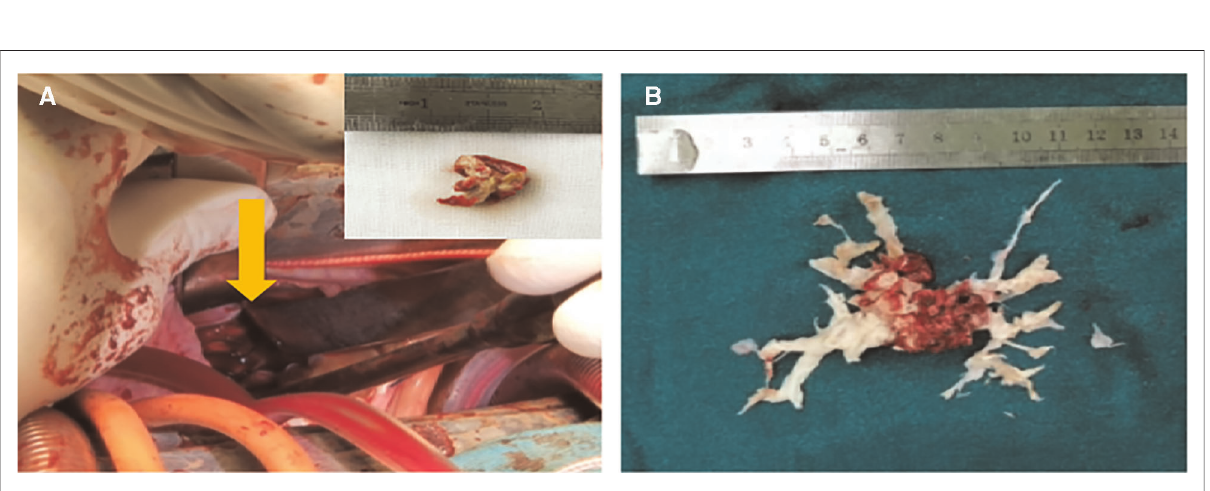
FIGURE 3 ( A ) The right ventricular mass found during the operation. ( B ) The denuded pulmonary artery intima during